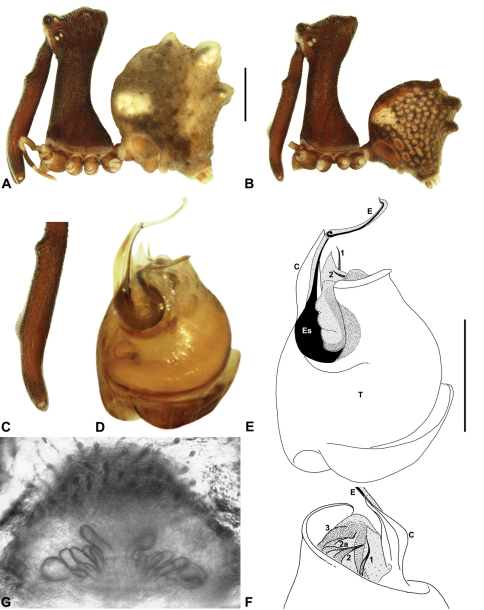
Austrarchaea nodosa (Forster, 1956). A–B, Cephalothorax and abdomen, lateral view: A, female (QMB S75416) from Lamington National Park, Queensland; B, male (QMB S75416) from Lamington National Park, Queensland. C, Male chelicerae, lateral view, showing accessory setae. D–F, Male (WAM T89592) pedipalp: D–E, bulb, retrolateral view; F, detail of distal tegular sclerites, prodistal view. G, Female (QMB S75416) internal genitalia, dorsal view. C = conductor; E = embolus; Es = embolic sclerite; T = tegulum; (TS)1–3 = tegular sclerites 1–3. Scale bars: A–B = 1.0 mm; E = 0.2 mm.